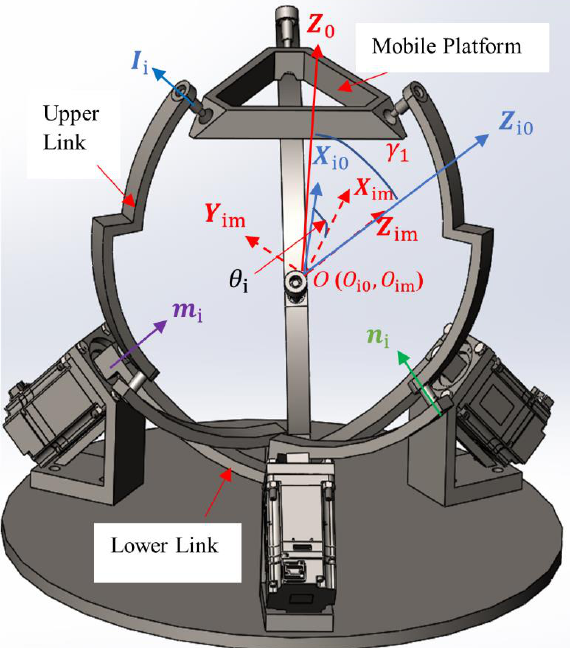
Figure 2. The position and direction of the frame L and the definition of 𝜃 i . Define 𝒁 i0 along the 𝒎 i axis, and further define 𝑿 i0 as perpendicular to 𝒁 i0 and along the direction such that initially, 𝑿 im is coincident with 𝑿 i0 , where the mobile plat- form is at the horizontal state. The origin of the frame 𝑿 i0 ( 𝒀 i0 ) 𝒁 i0 is also at O , denoted as 𝑂 i0 , due to the spherical property of the SPR. For the convenience of later discussions, denote the frame 𝑂 i0 - 𝑿 i0 ( 𝒀 i0 ) 𝒁 i0 as the frame O i , denote the frame 𝑂 il - 𝑿 il ( 𝒀 il ) 𝒁 il as the frame I, denote the frame 𝑂 im - 𝑿 im ( 𝒀 im ) 𝒁 im as the frame L, the frame 𝑂 in - 𝑿 in ( 𝒀 in ) 𝒁 in as the frame U. Define 𝜃 i as the angle between 𝑿 i0 and 𝑿 im , see Figure 2. Define 𝜇 i as the angle between 𝑿 im and 𝑿 in , see Figure 3. Further from Figures 2 and 3, 𝛽 1 is the angle be- tween 𝒁 im and 𝒁 in ; 𝛽 2 is the angle between 𝒁 in and 𝒁 il ; 𝛾 1 is the angle between 𝒁 i0 and 𝒁 0 ; and 𝛾 2 is the angle between 𝒁 ’ and 𝒁 il . It is noted that these four angles are iden- tical to each leg. Table 1 shows the D-H parameters of the lower link and upper link, which are associated with the three coordinate systems, namely the frame O i , the frame L, and the frame U.